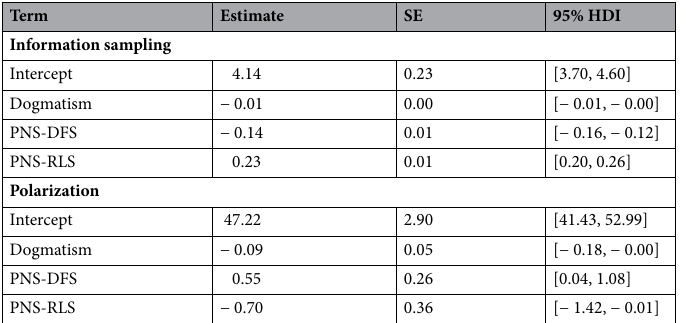
Table 2. Estimates of the effects of Dogmatism, Personal Need for Structure Reaction to Lack of Structure subscale (PNS-RLS), and Personal Need for Structure Desire for Structure subscale (PNS-DFS) on polarization (K-L divergence, bottom) and information search (number of clicks on the sampling button on each trial,